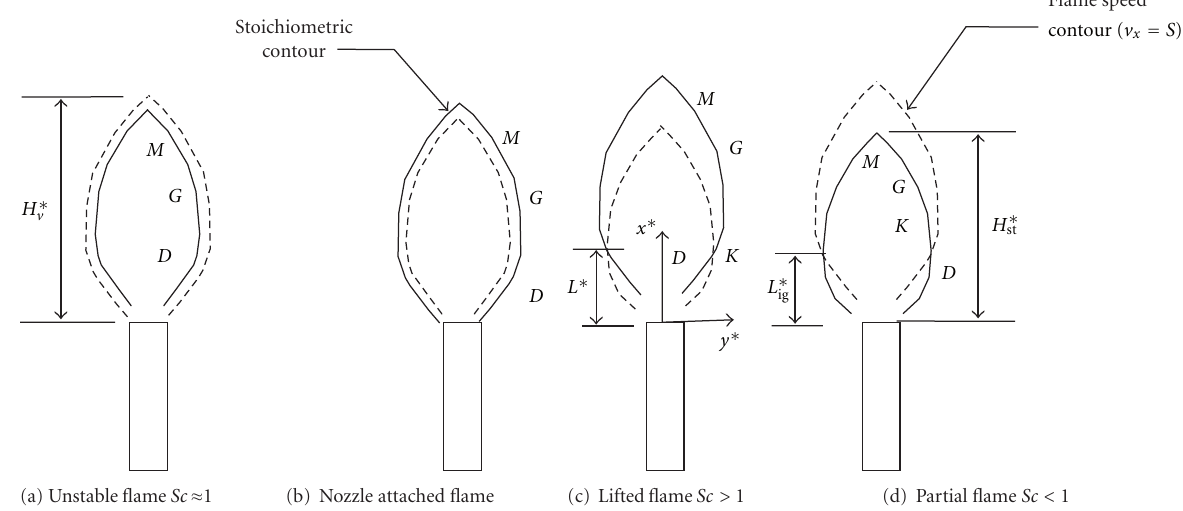
can lie “outside” the flame speed contour (Figure